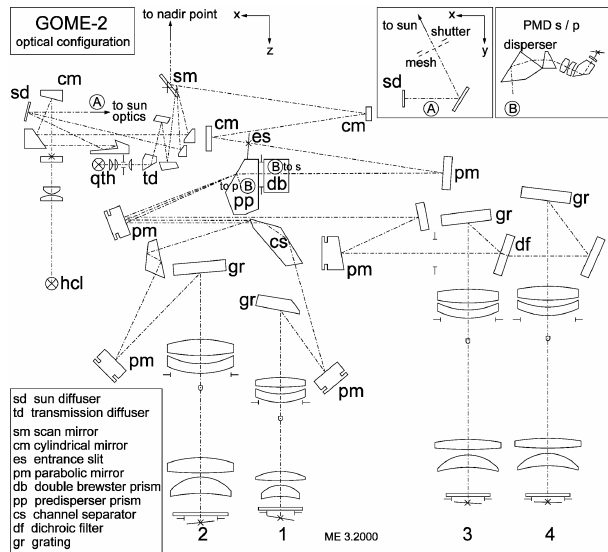
Figure 2. GOME-2 optical layout. The optics are in one plane (ex- cept insets A and B). Nadir is in − Z direction (graphic provided courtesy of Selex Galileo). Note that the PtCrNeAr spectral light source (SLS) for wavelength calibration is indicated as “hcl”, and the Quartz Tungsten Halogen white light source (WLS) as